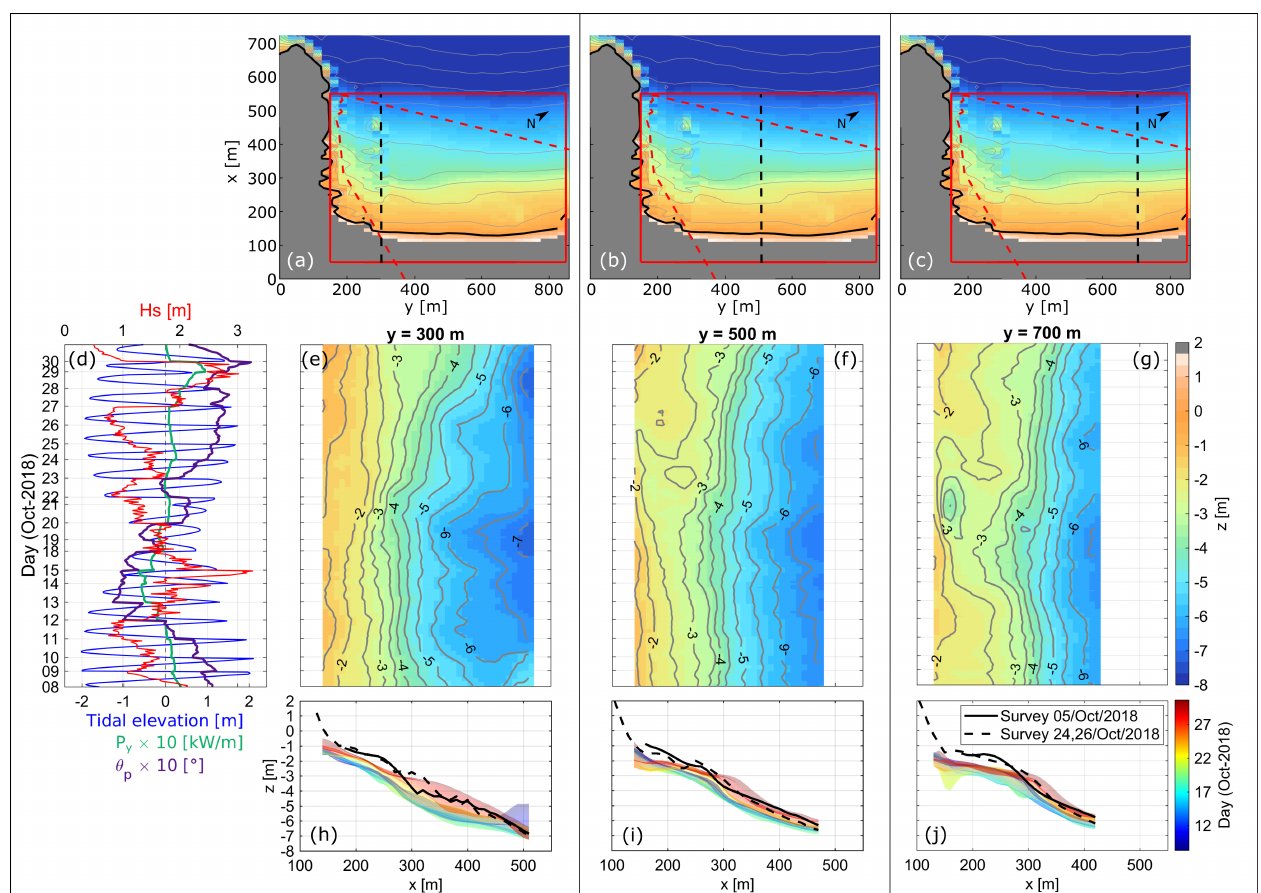
Figure 9. LPCA beach cross-shore profile morphological evolution over October 2018 derived from 2-day time-averaged Kalman-filtered cBathy estimates. ( a – c ) The cross-shore profile transects are indicated by the black dashed lines. The red polygon shows the domain used for analysis and the red dashed lines indicate the limits of video-monitoring coverage. ( d ) Offshore significant wave height H s (red line; top axis), tidal elevation (blue line; bottom axis), 12 h averaged alongshore wave energy flux (green line; bottom axis) and 12 h averaged angle of peak wave incidence θ p (purple line; bottom axis) time series corresponding to the computed cBathy Kalman-filtered stacks. ( e – g ) cBathy -derived timestacks along with ( h – j ) the time evolution of each cBathy cross-shore profile (shown with different colors). The solid and black dashed lines correspond, respectively, to profile transects obtained from bathymetry (5/Oct/2018) and topo-bathymetry (24,26/Oct/2018) surveys. For better visualization, the time is concatenated during available cBathy stacks (i.e., nightlight hours and absent data from 16 and 17 October are